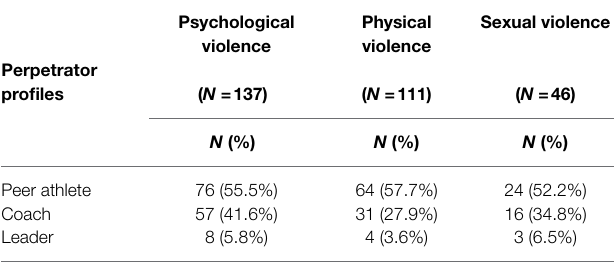
TABLE 3 | Perpetrator profiles for the three forms of